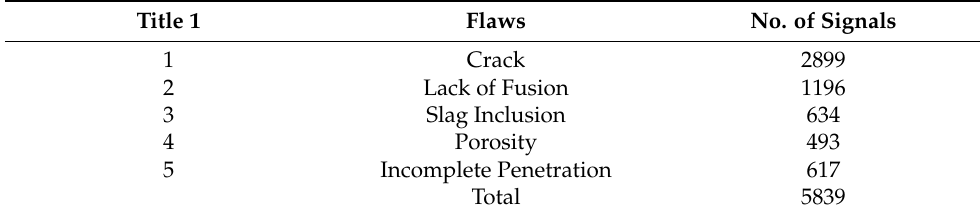
Table 2. Ultrasonic weldment flaw database.